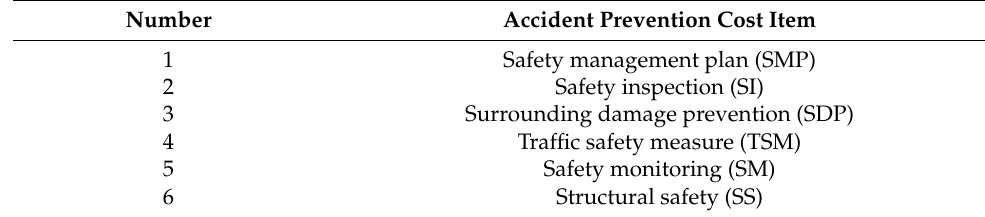
Table 3. APC items of safety management expenses.